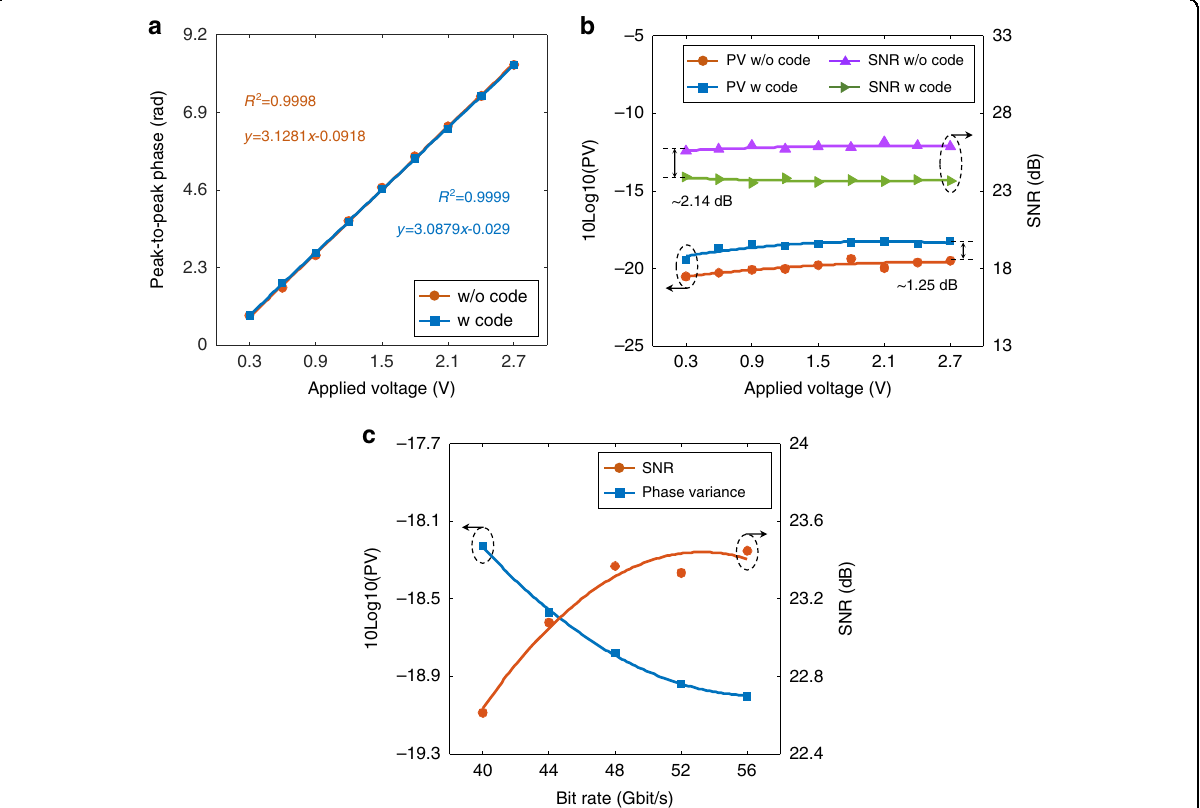
Fig. 8 The effect of the transmission code on the sensing performance in the ISAC-OF. a Comparison of the sensor response using a pure LFM optical probe (w/o code) and ISAC-OF (w code). b Comparison of the sensing accuracy (which is determined by PV) and SNR in the conventional LFM-based Φ -OTDR and ISAC-OF. c The effect of the bit rate of the transmission code on the sensing